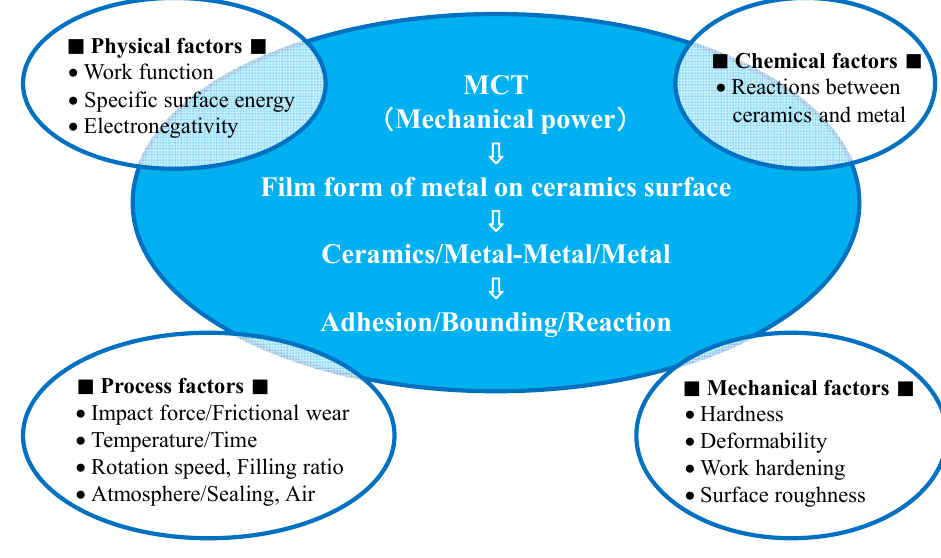
Figure 4. The influence parameters of MCT in theory.